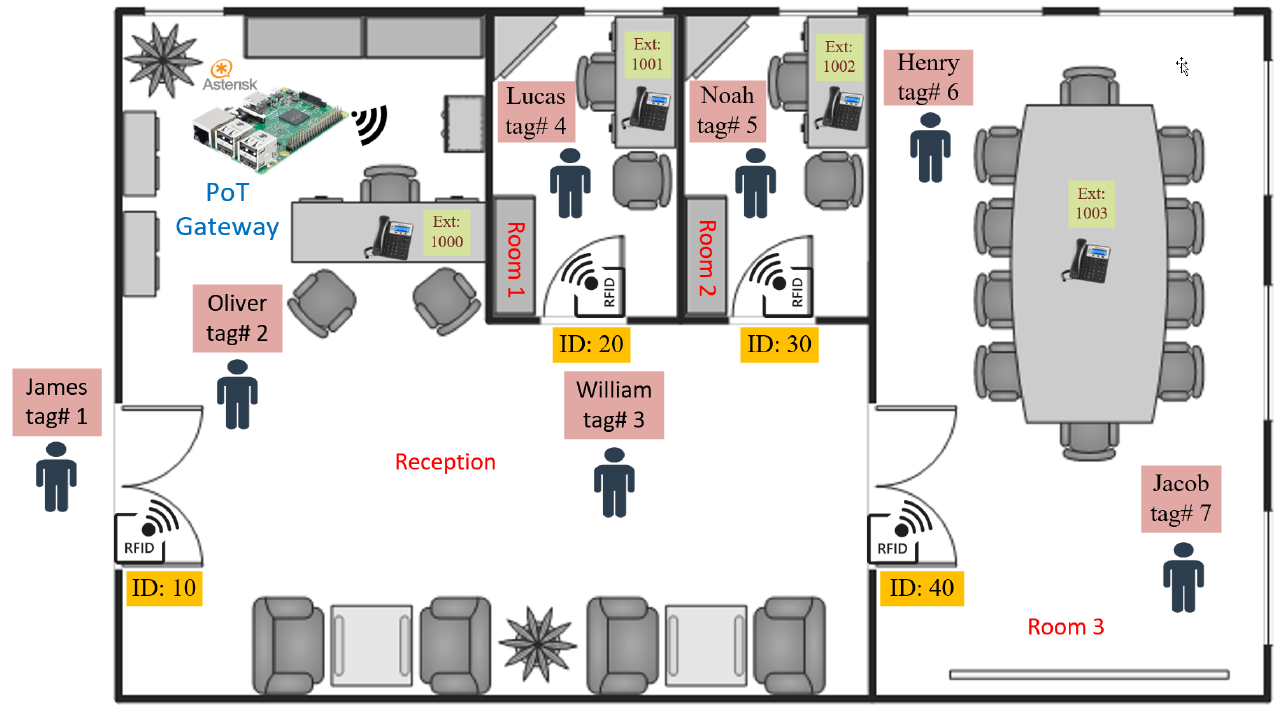
Figure 15. Entering and exiting example scenario. Table 3. Truth table of the example scenario’s floor